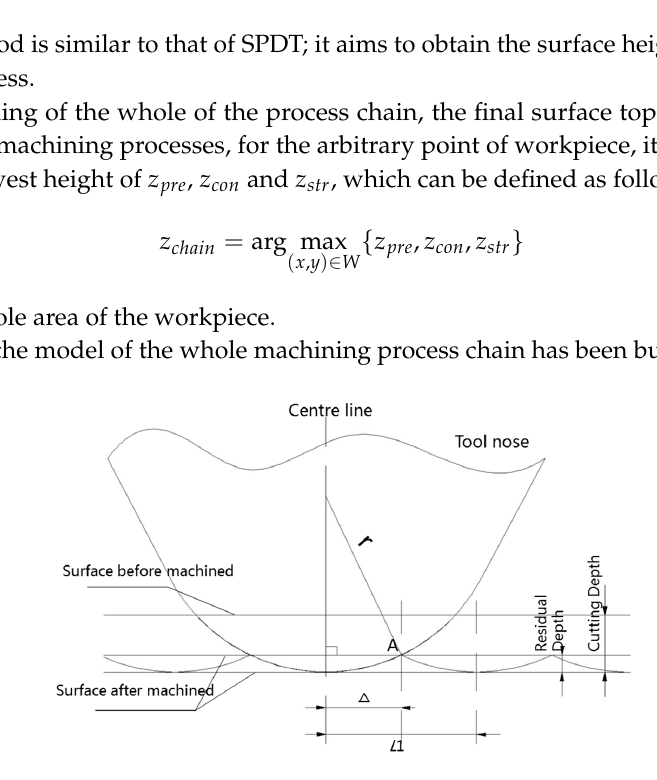
Figure 6. MPC3 (Combining SPDT and diamond broaching process) of machining polar microstructure.